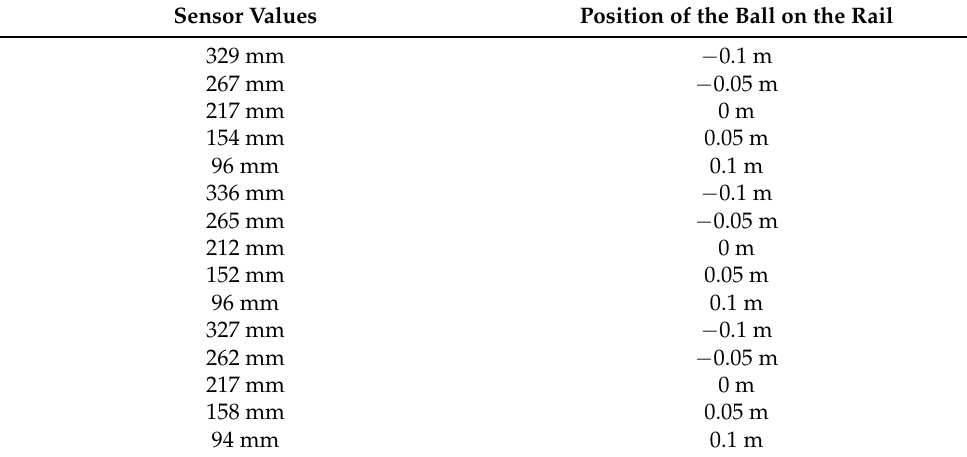
Table 5. Values for position sensor calibration. Sensor Values Position of the Ball on the Rail 329 mm − 0.1